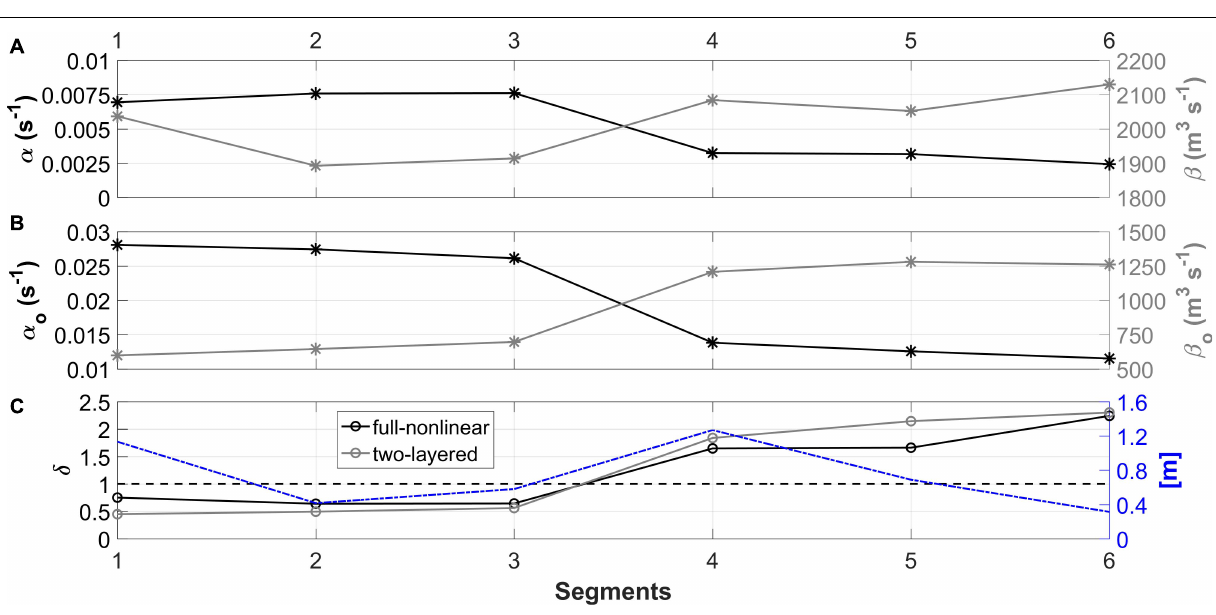
FIGURE 4 | (A) The coefficients that parameterize nonlinear steepening α (black) and dispersion β (gray) effects on PIL200 through the full-nonlinear method calculated for each relevant 2-day segment (S1 to S6). (B) The same estimation through two-layered solutions α 0 (black) and β 0 (gray). (C) The dimensionless form relating the environmental parameters δ (black) and δ 0 (gray) and the averaged ebb tidal amplitudes from the adjusted generation scenario (delayed of ∼ 13 h; blue); the horizontal dashed line marks the criterion of dimensionless parameters equal the